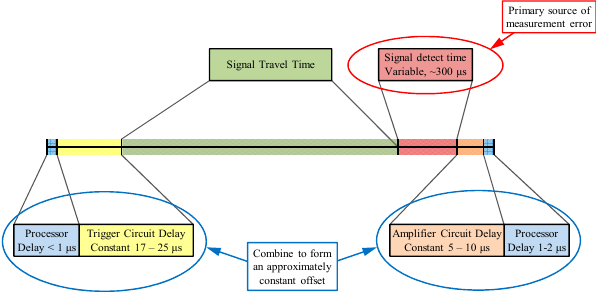
Figure 8. Signal timeline and sources of error (not to scale).